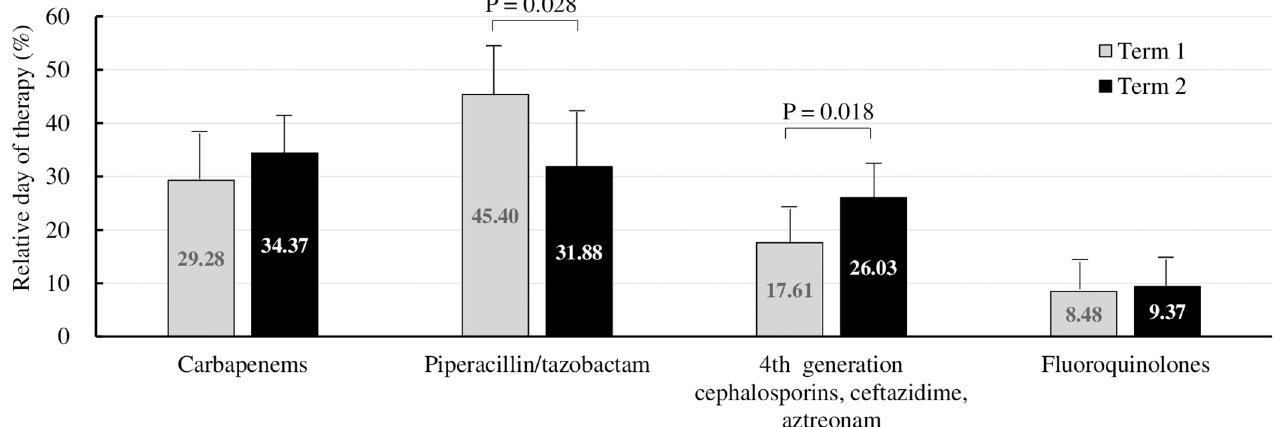
Fig 3. Relative day of therapy of each broad-spectrum antibiotic commonly used for hospital-onset infections in term 1 and term 2 after establishment of a new antibiotic stewardship team in the community hospital. Gray bar shows DOT in term 1 and black bar shows DOT in term 2.